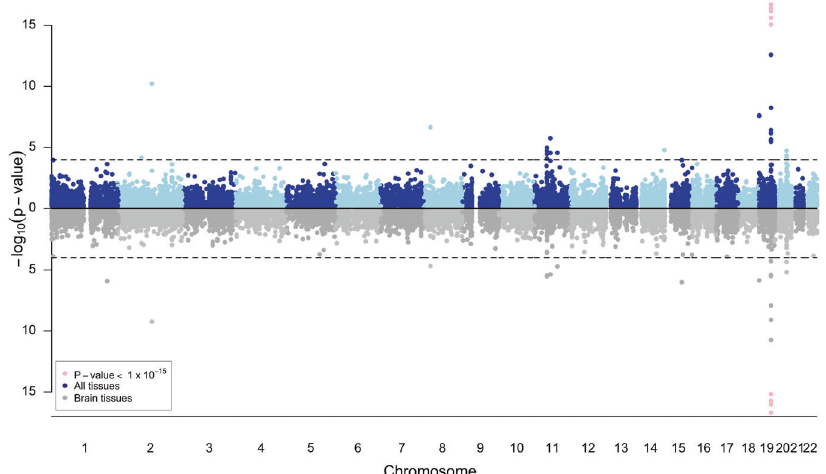
Fig. 2 Miami plot of cross-all GTEx tissue (blue dots, top) and cross-brain tissues model (gray dots, bottom). p -values less than 1 × 10 − 15 (pink dots) were truncated to improve the clarity of peaks in other, less signi fi cant